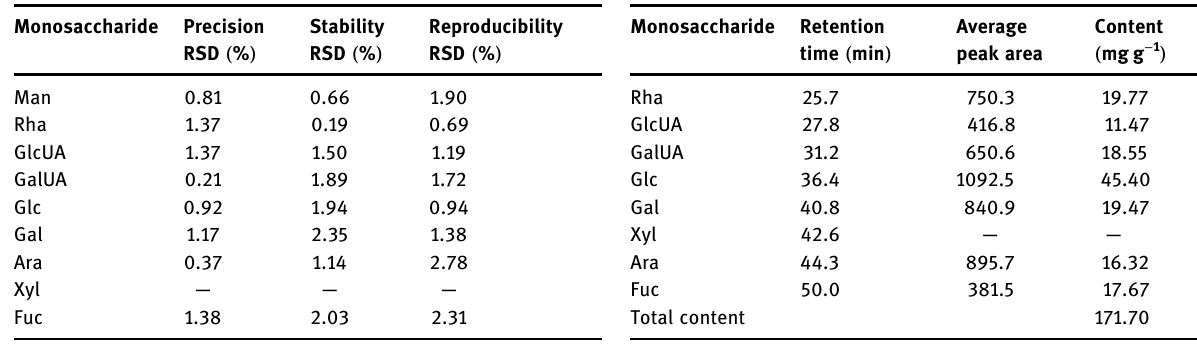
Table 6: Content determination result of monosaccharides in RPS ( n = 3